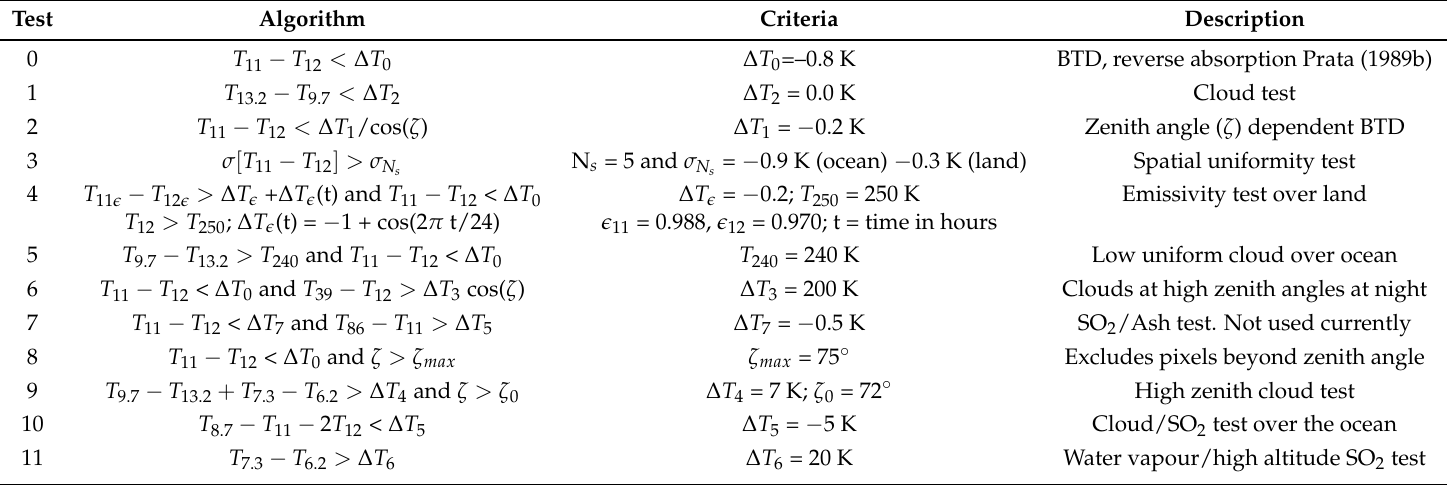
Table 6. Infrared cloud tests to identify cloudy pixels in SEVIRI imagery. Test parameters and thresholds have been tuned and may need adjusting from time and time. Test